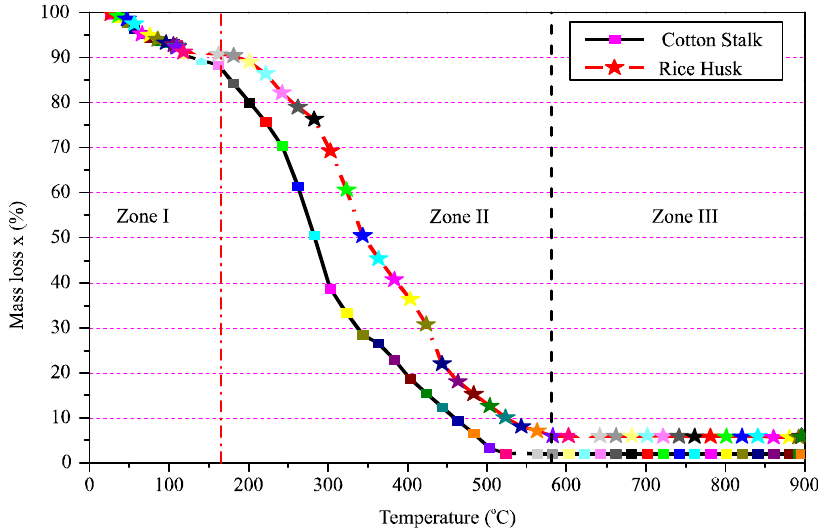
FIG. 4. TGA CURVE OF COTTON STALKS AND RICE HUSK SAMPLES UNDER OXIDATIVE ENVIRONMENT